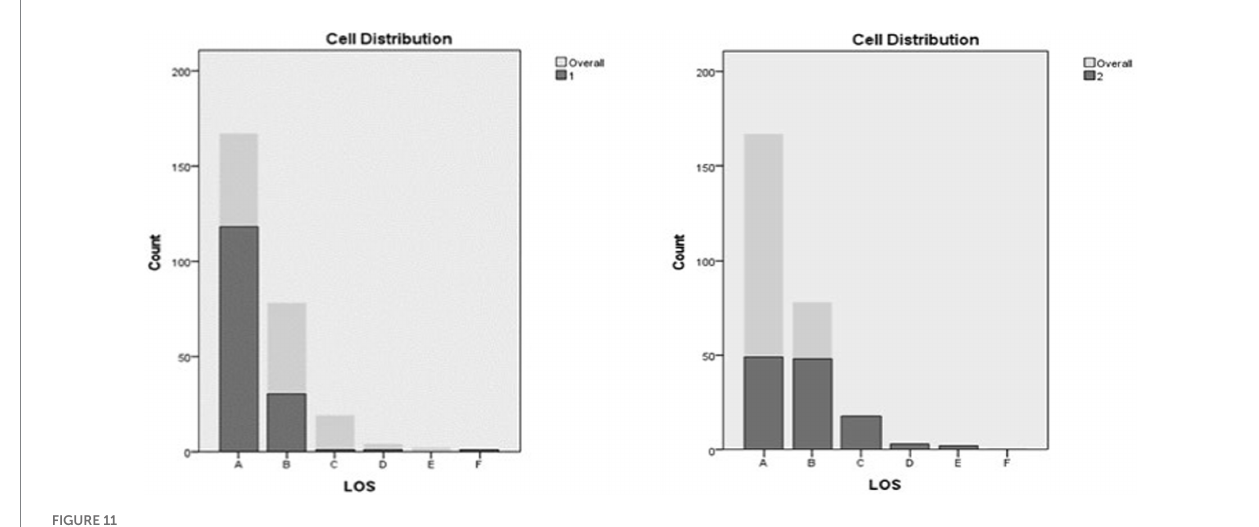
FIGURE 11 Level of service (LOS) distribution in clusters.